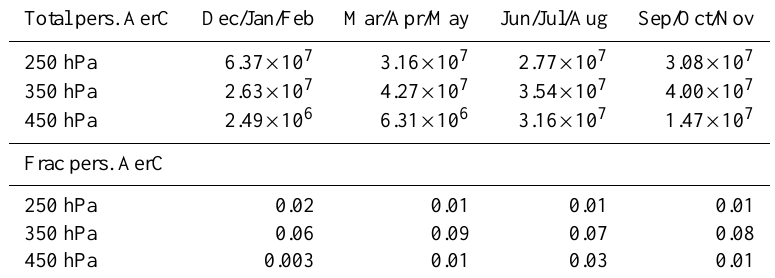
Table 2. Flight distances with persistent aerodynamic contrails: 1st part – flight distances in km; 2nd part – fractions of the total flight distances where aerodynamic contrails would be